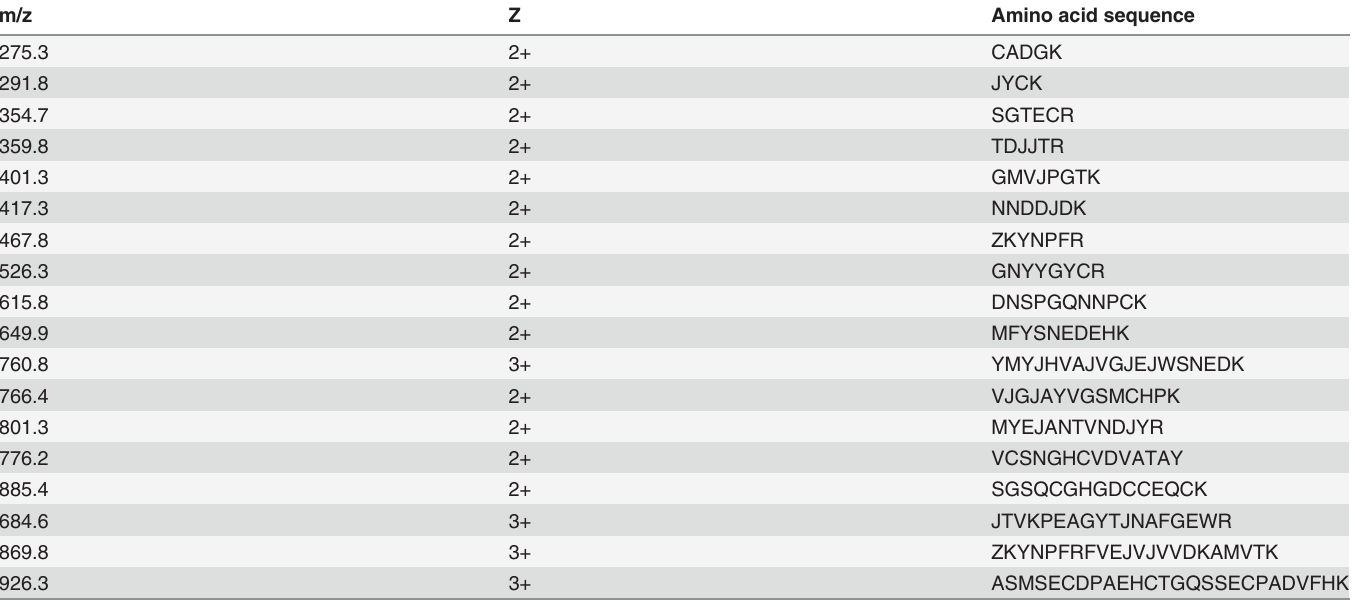
Table 1. Tryptic peptide ion sequences obtained by de novo CID-MS/MS sequencing of Crotalus simus PIII SVMP. m/z Z Amino acid sequence